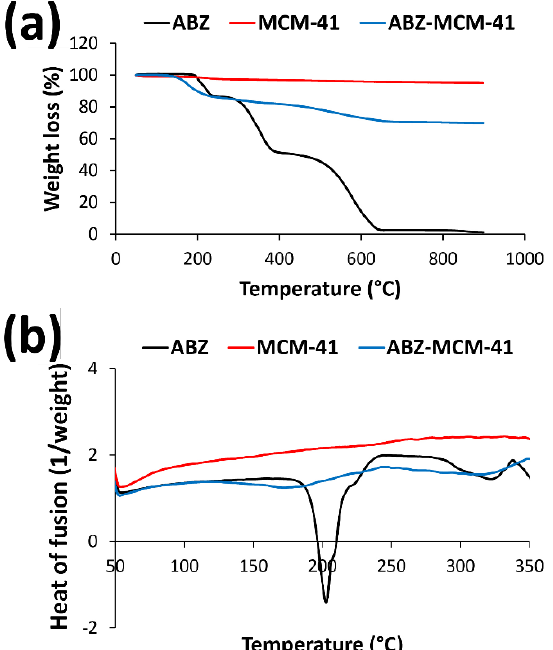
Figure 3: (a) Thermogravimetric analysis (TGA) thermograms of albendazole (ABZ), Mobil Com- position of Matter No. 41 (MCM-41), and ABZ- loaded NPs and (b) differential scanning calorim- etry (DSC) profiles of ABZ, MCM-41, and ABZ- MCM-41 NPs. Panel a shows, MCM-41 NPs ex- perienced an initial weight loss at 250 °C, resulting in approximately 3 % weight loss. ABZ-loaded NPs were also decomposed at two temperatures, 150 and 450 °C, and this decomposition led to a decrease of 30 % in the mass of the formulation. In addition, ABZ was completely degraded when the temperature reached 900 °C. In panel b , pure ABZ showed a melting endothermic peak around 200 °C, while there were no obvious peaks in the thermogram of MCM-41 NPs. A melting endother- mic peak but not sharp was also observed in the thermogram of ABZ-MCM-41 NPs at around 170 °C, which could be attributed to the crystalline anhydrous state of